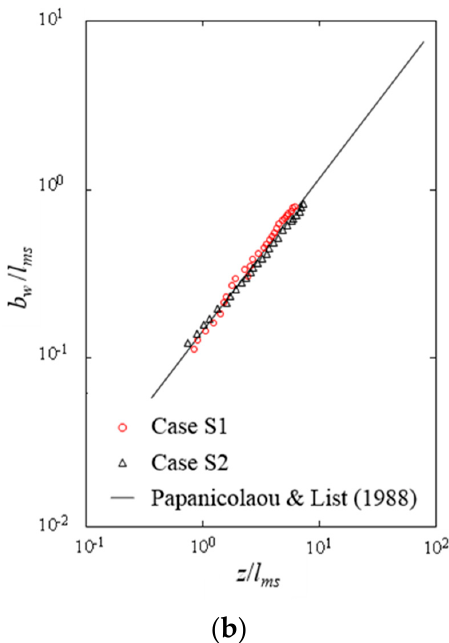
Figure 4. ( a ) Centerline velocity w c decay along the axis, and ( b ) half-width b w of single buoyant jet in still water.